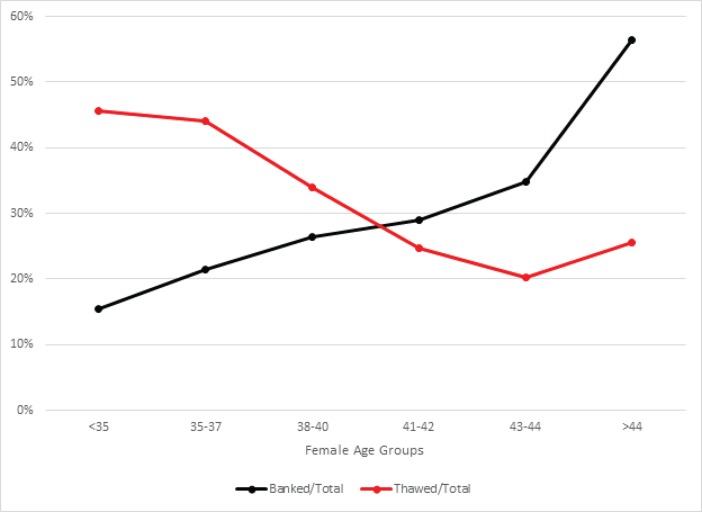
Percentage of banked and thawed cycles per total initiated fresh ART cycles in 2013.